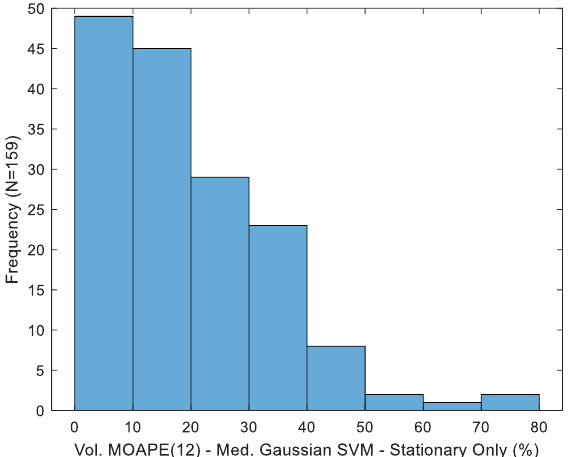
Figure 9. Distribution of volume mean overall absolute percentage error after 12 drinks for the best-case estimator.